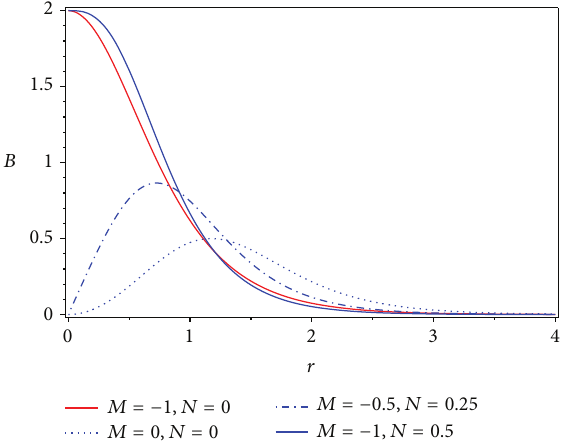
Figure 4: The profiles of the magnetic field 𝐵(𝑟) for 𝑛 = 1 . The red lines represent the solutions for a |𝜙| 4 potential and blue lines for |𝜙| 6 potentials.